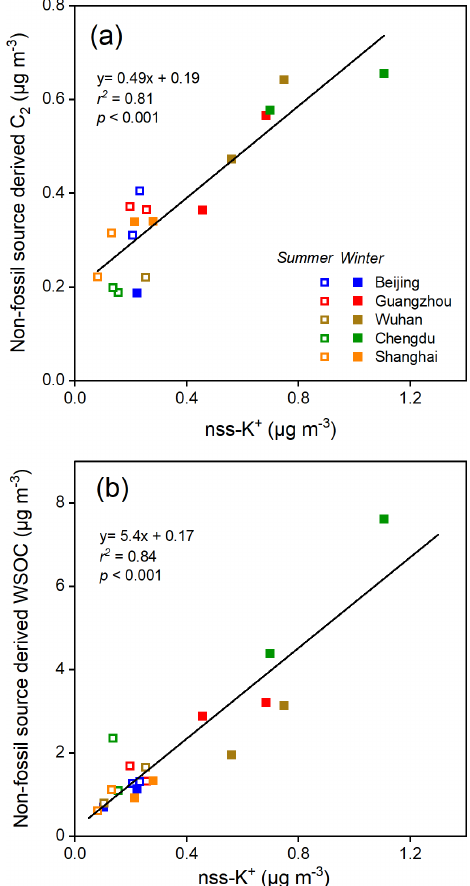
Figure 3. Relationships between (a) non-fossil-derived oxalic acid concentrations and non-sea-salt potassium (nss-K + ) concentrations and between (b) non-fossil-derived, water-soluble organic carbon (WSOC) concentrations and nss-K +